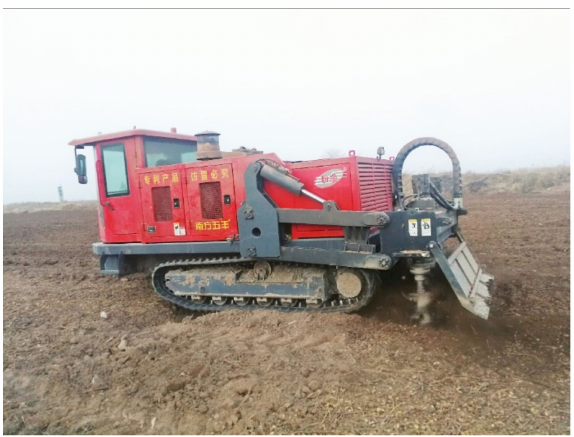
Figure 3. Deep loosener machine for smashing ridge tillage